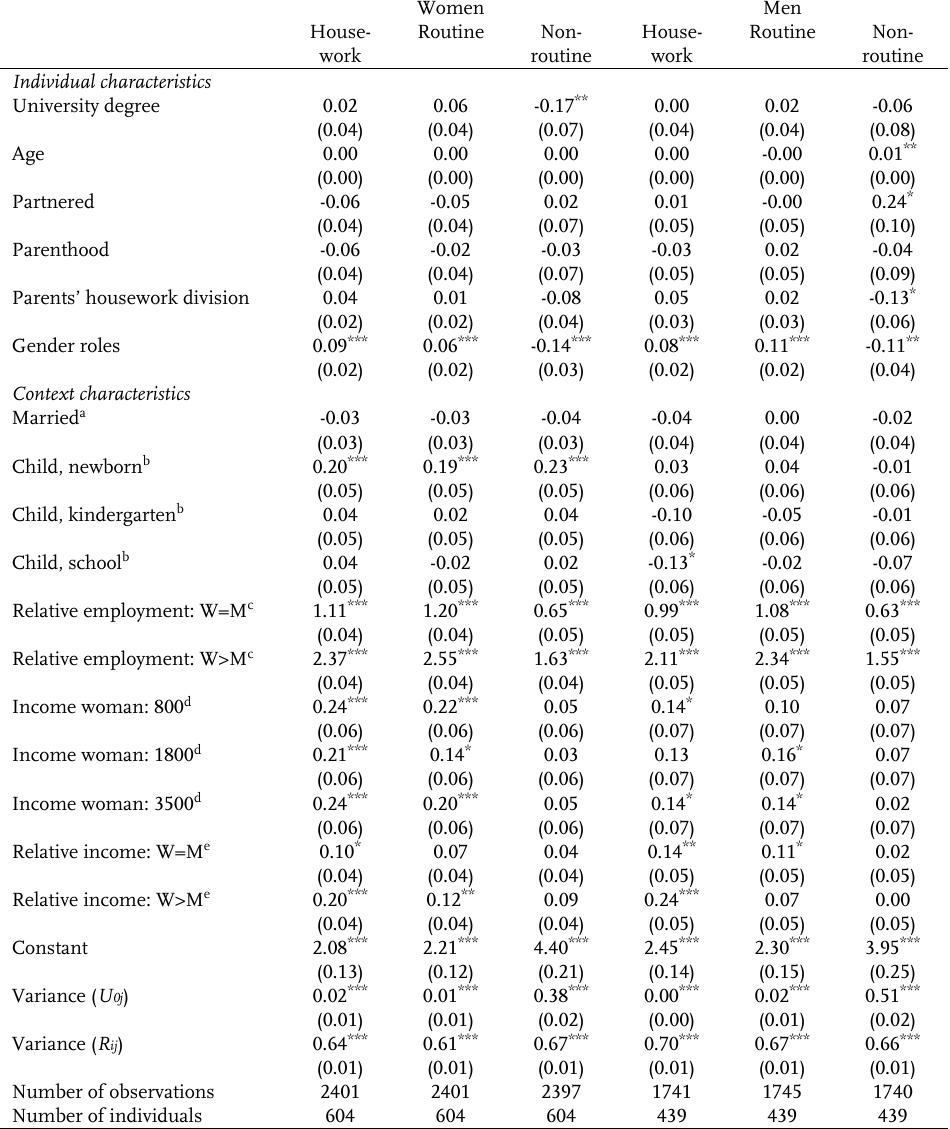
Table B.2 : Multilevel linear regression models for the attitudes towards sharing housework in general, routine housework, and non-routine